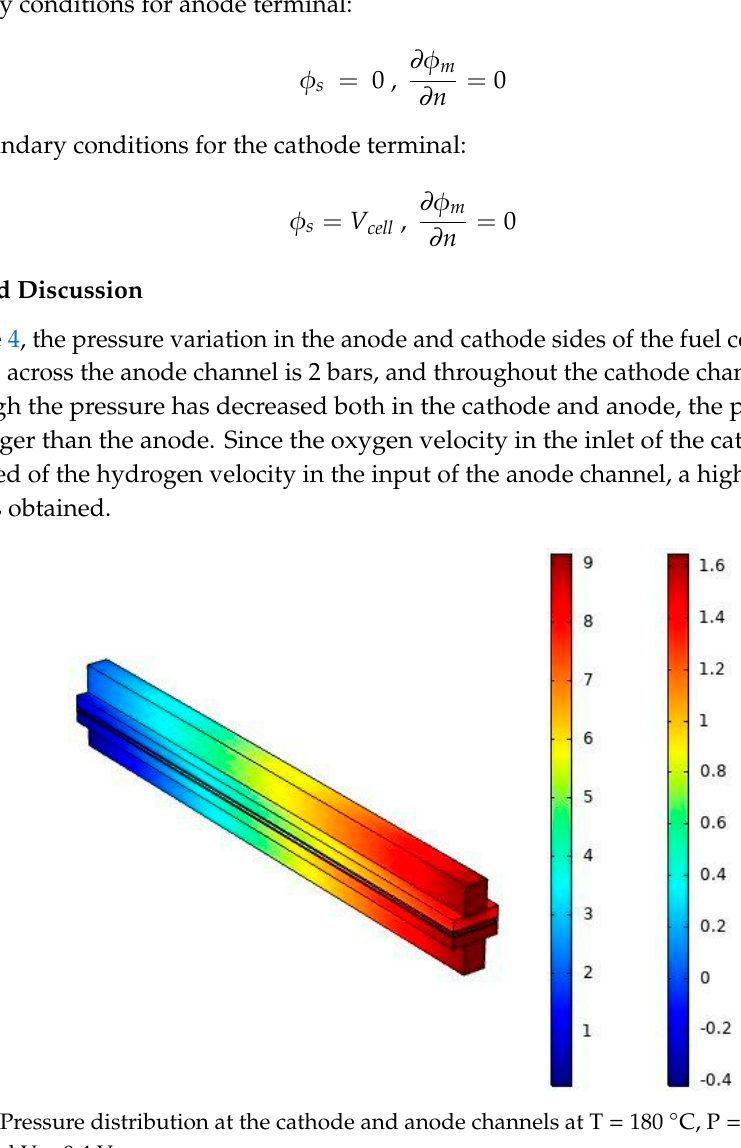
Figure 5. Pressure effect on the current density at T = 180 °C, st (cid:2911) = 1.2 , st (cid:2913) = 2. The concentration of reactive species, namely, hydrogen (Figure 6a) and oxygen (Figure 6b), are shown in Figure 6 at 180 °C and at a voltage of 0.4 V. As can be seen, the highest concentration is at the channel entrance, and the concentration of species decreases towards the channel outlet, as the species entering the anode and cathode channel, the reaction is started and species are consumed to generate current density According to figure, the oxygen concentration along the cathode channel